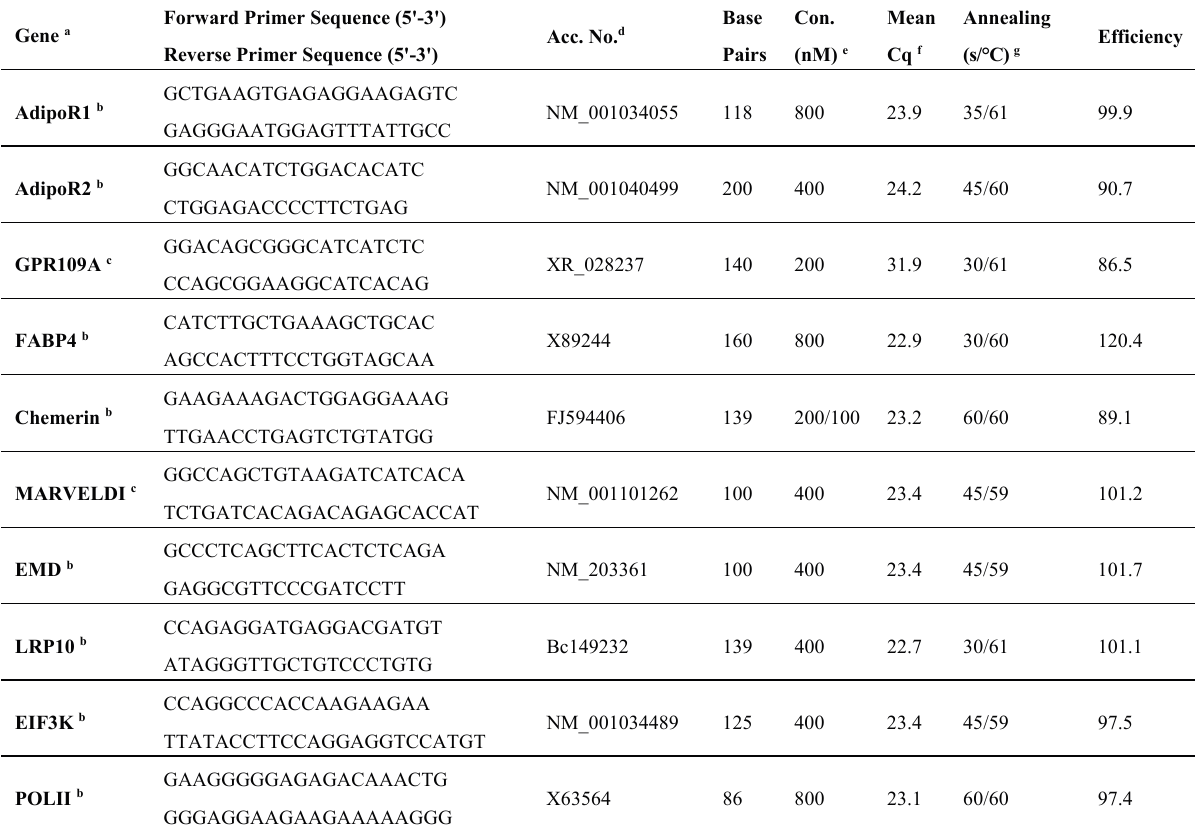
Table 2. Characteristics of the primers and the quantitative real-time PCR conditions. Gene